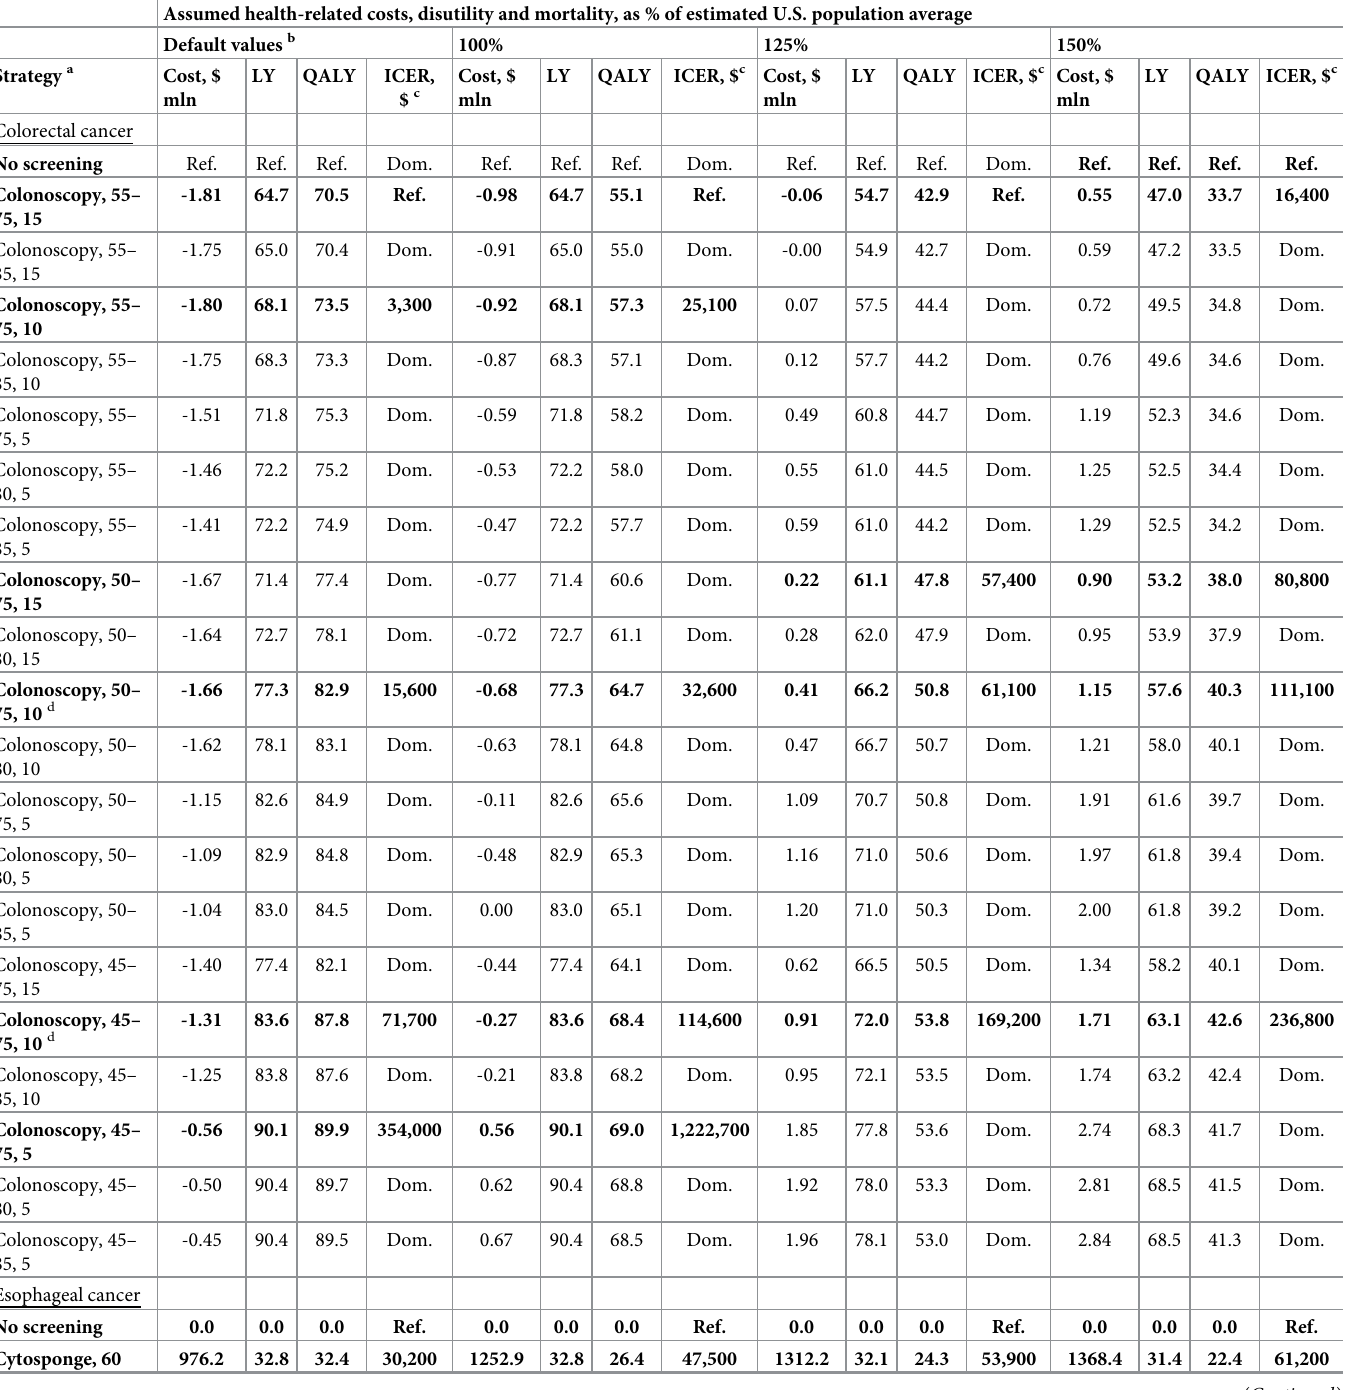
Table 1. Cost and effects of colorectal cancer (CRC) and esophageal adenocarcinoma (EAC) screening incremental to no screening, under various assumed values for the future health-related costs, disutility and mortality, per 1,000 adults. Assumed health-related costs, disutility and mortality, as % of estimated U.S. population average Default values b Strategy